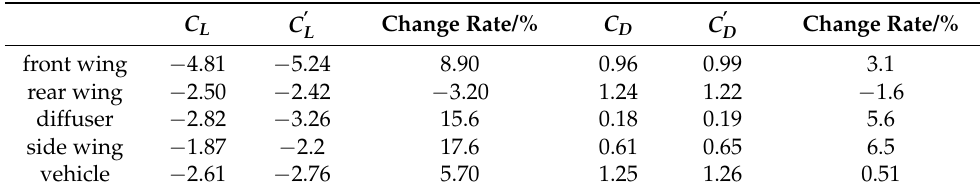
Table 7. Comparison of coefficients before and after implementing the shutters.